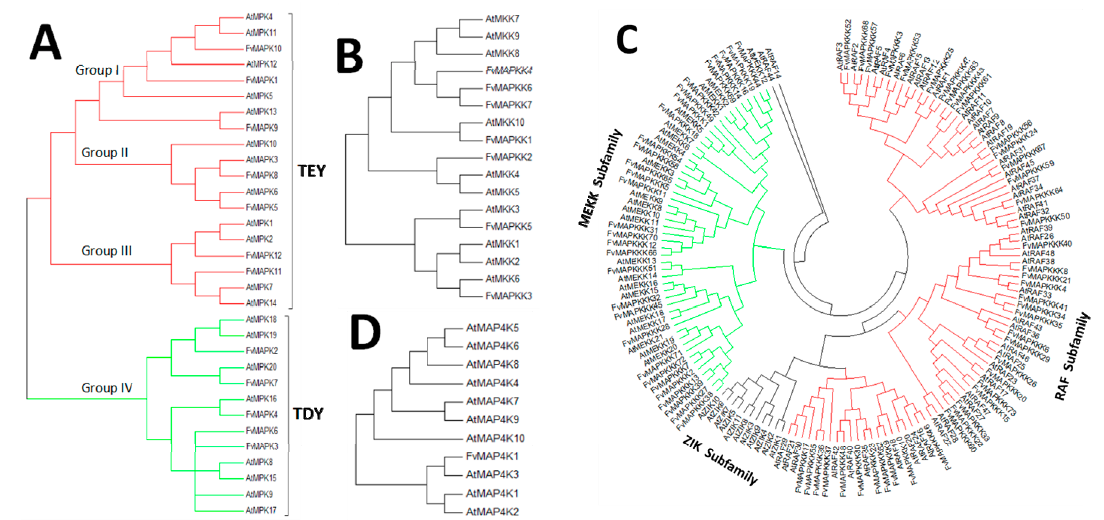
Figure 3. Phylogenetic relationships between MAPK cascade proteins from Arabidopsis thaliana and strawberry: ( A ) phylogenetic relationship between A. thaliana and FvMAPK proteins, red lines show TEY group; ( B ) phylogenetic relationship between A. thaliana and FvMAPKK proteins, green lines show TDY group; and ( C ) phylogenetic relationship between A. thaliana and FvMAPKKK proteins. MAPKKK forms the largest group of MAPK cascade proteins with 73 members classified into two subfamilies, MEKK (green lines) and Raf (red lines), which contain 30 and 43 genes in the Fragaria vesca and A. thaliana genomes. ( D ) Phylogenetic relationship between A. thaliana and strawberry MAPKKKK proteins.